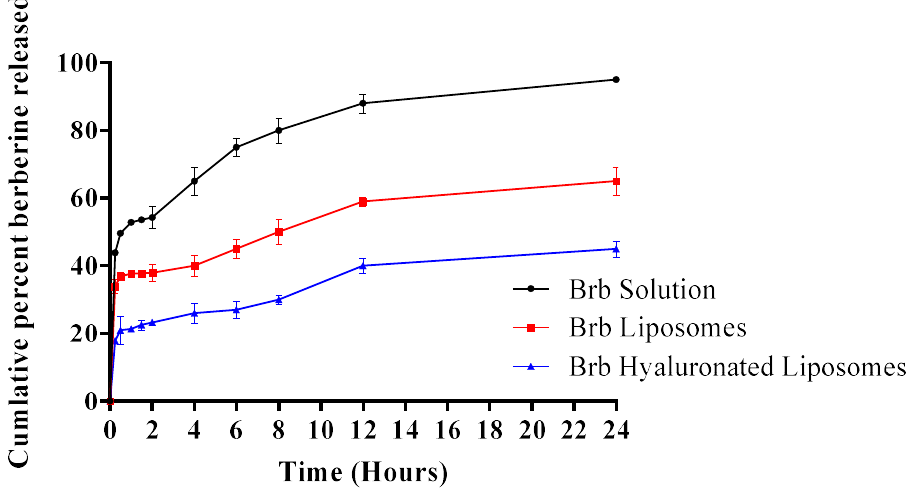
Figure 3. Cumulative in vitro release of berberine from different berberine formulations in phosphate buffer saline (pH 6.8), each result is the mean of three determinations ±